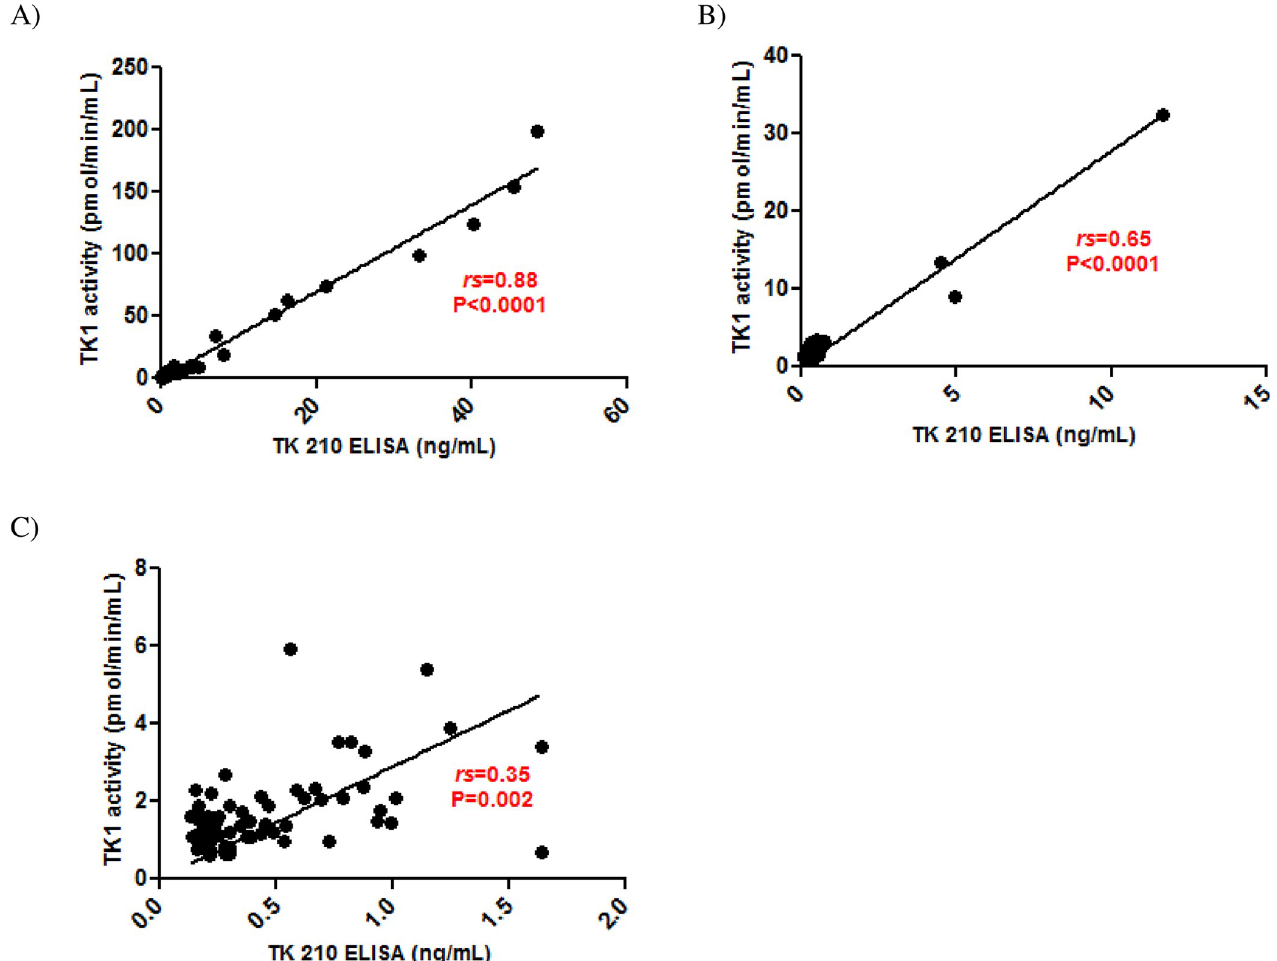
Fig 10. Correlation between TK 210 ELISA and TK1 activity assays for different malignancies. (A) hematological malignancies (B) breast cancer (C) prostate cancer.